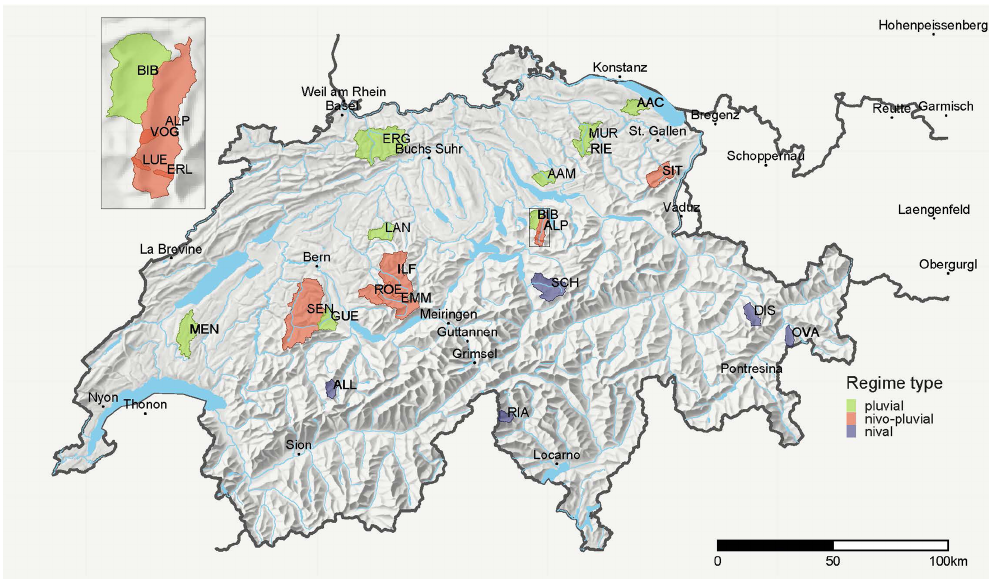
Figure 1. Map of the sampling locations and related catchments in Switzerland. The zoomed-in inset shows the five Alptal catchments. Black dots indicate the source stations for the interpolation of the isotopic compositions in precipitation. The source of the underlying relief map is the Swiss Federal Office of